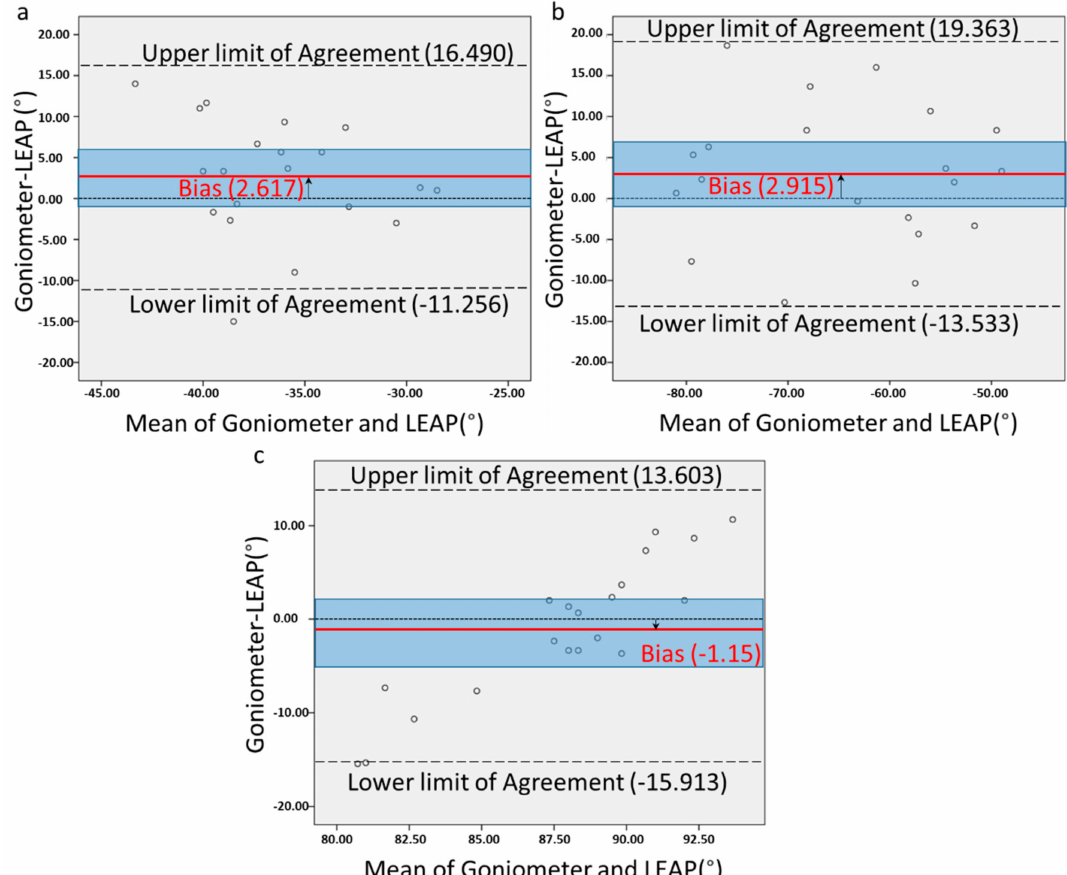
Figure 4. Bland-Altman plots of ( a ) wrist ulnar deviation, ( b ) wrist extension and ( c ) Index finger MCP flexion. The y-axis shows the difference, while the x-axis the mean between goniometer and Leap motion sensor for every participant (20 participants/dots). The red line shows the mean difference (bias) for the two measurement techniques. The blue shaded area is the 95% CI for the mean difference. For these three movements the line of equality (line crossing zero) is included inside the shaded area. The two dashed lines show the limits of agreement ( ± 1.96*SD), between the two measurement